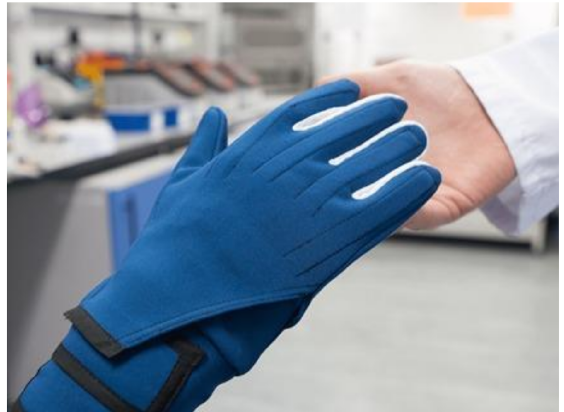
Figure 27. ActionSense smart glove [60].